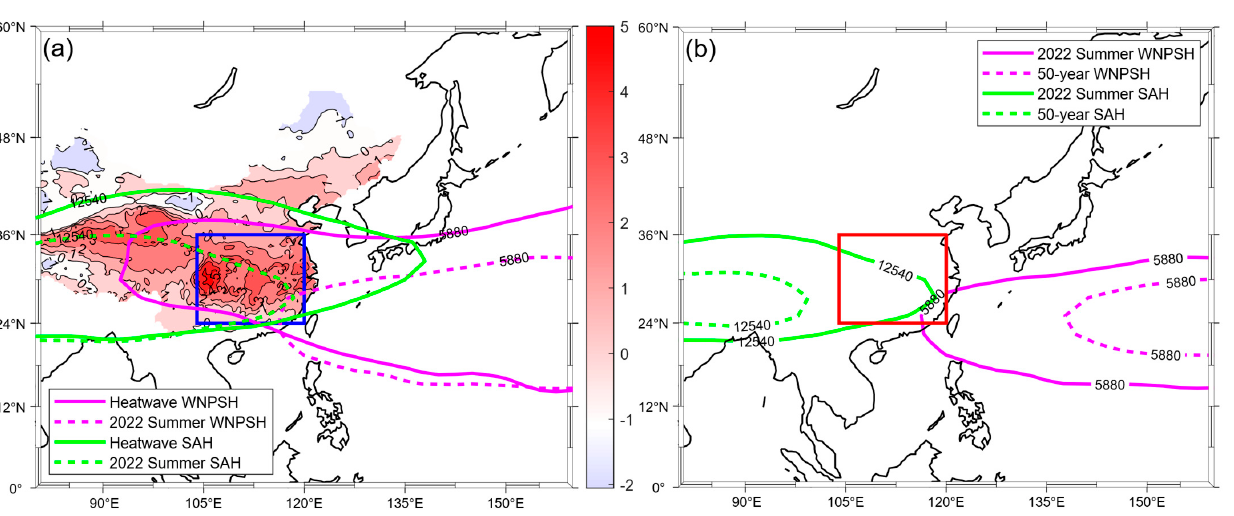
Figure 5. ( a ) Mean location of SAH (green solid line) and WNPSH (pink solid line) and temperature anomaly during the heatwave event (shading; °C) compared with the 2022 summer average location of SAH (green dashed line) and WNPSH (pink dashed line). ( b ) The 2022 summer mean location of SAH (green solid line) and WNPSH (pink solid line) compared with the climatology locations (dashed lines). The location of SAH is marked by the 12,540 gpm line in 200 hPa and the location of the WNPSH is marked by the 5880 gpm line in 500 hPa. The red and blue box marks South China.